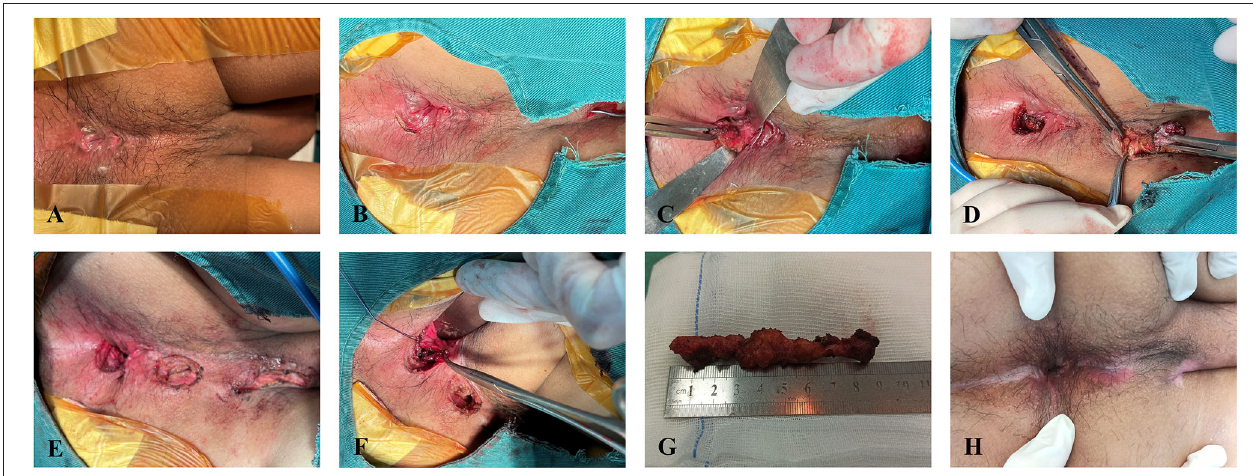
FIGURE 1 | Sphincter-preserving fistulectomy procedure. (A) A semi-horse high-transsphincteric fistula. (B) An intersphincteric curvilinear incision. (C) Dissection of the intersphincteric tract to the external anal sphincter after being cut off adjacent to the internal anal sphincter. (D) Coring out the remnant tract. (E) Suture repair of the defect on the external anal sphincter after core-out fistulectomy. (F) Partial suture of the lateral full-thickness flap after excising the internal opening. (G) Excised fistula specimen. (H) Normal anal morphology after wound